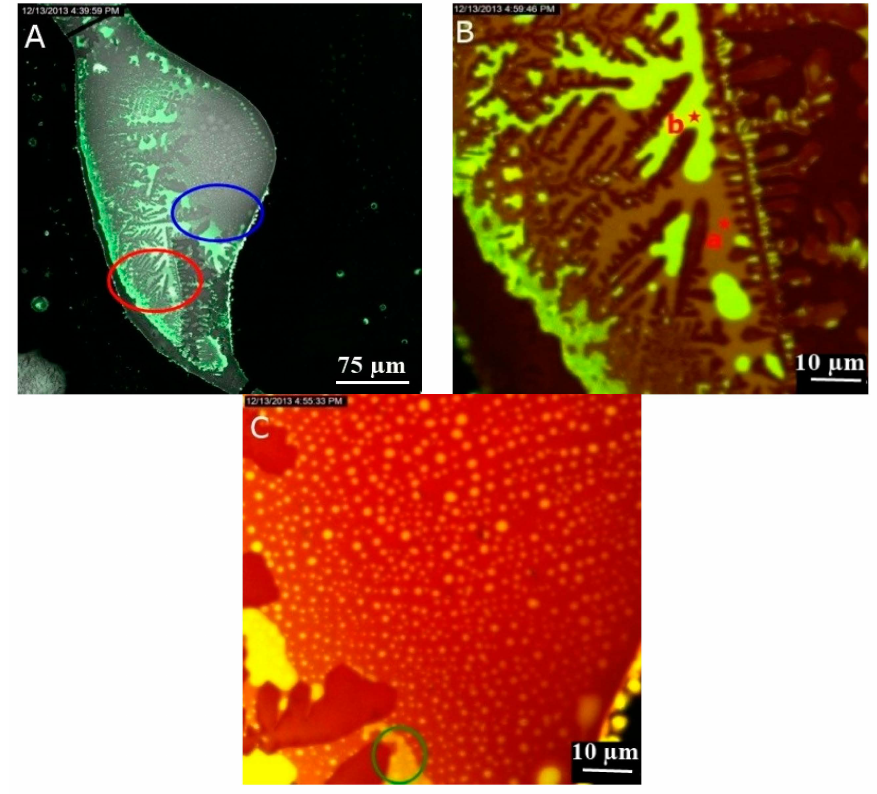
Figure 6. LSCM images of precipitated DNA/GNPs/solution. ( B ) and ( C ) are images of higher magnification at respectively the red and blue markets location in image ( A ). The 514 nm was used as pump beam. Light detected in (550–650) nm is green (Figure 6A,B) or yellow (Figure 6C) and light detected in (650–750) nm is red (Figure 6B,C) or grey (Figure 6A). The representation colors have been chosen to enhance the